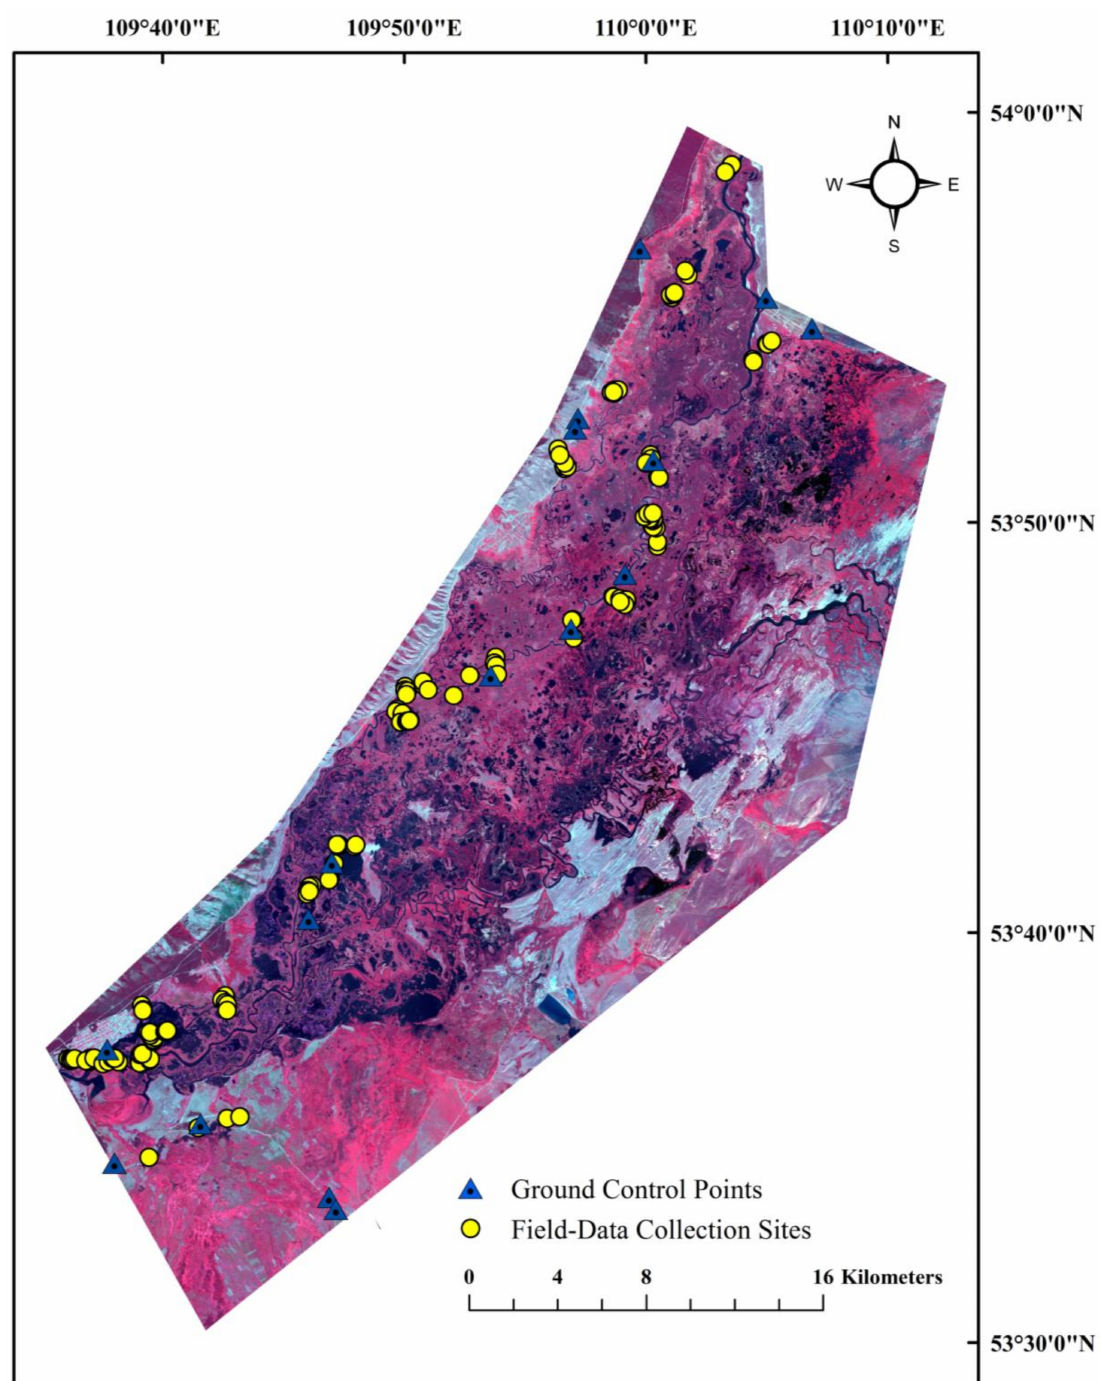
Figure 3. Field survey ( n = 142) and ground-control sites ( n = 16) within the lower Barguzin Valley study area overlain on an image composite (Quickbird bands 2, 3, and